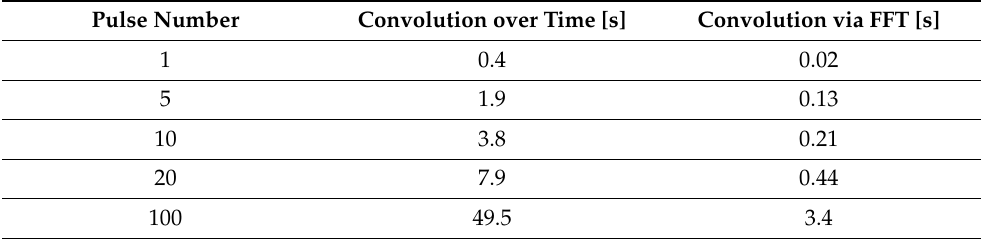
Table 1. Compared times of HPM pulse filtration